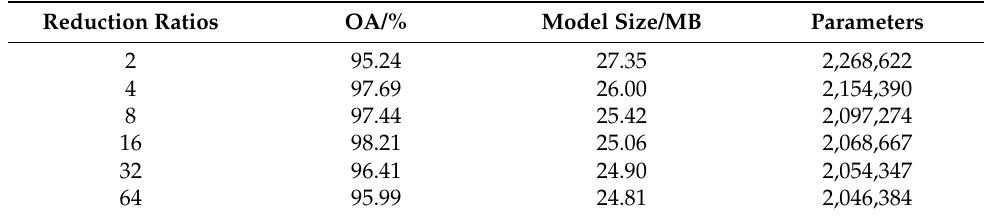
Table 3. Results of using reduction ratios for I_CBAM_MobileNetV2.